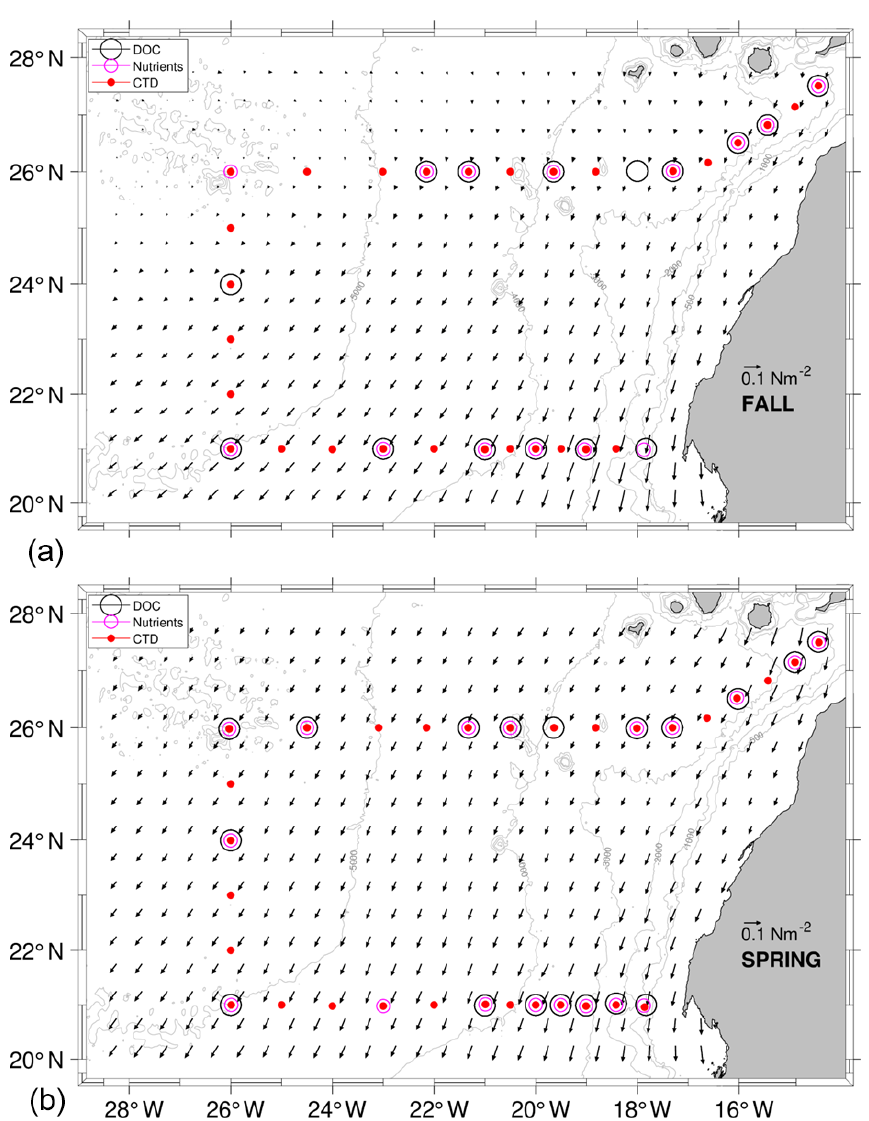
Figure 1. Hydrological (red dots), inorganic nutrient (pink circles) and DOC (black circles) sampling stations during the COCA-I (a) and COCA-II (b) cruises. Time-averaged wind stress during each cruise is also represented by the inset arrow denoting the scale (shown with half of the original spatial